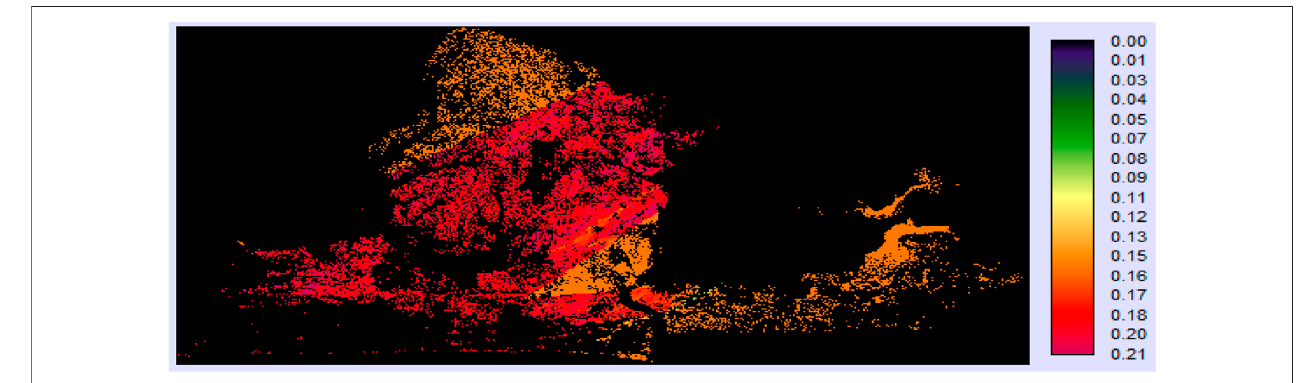
FIGURE 11 | Transition potential map for 2030.